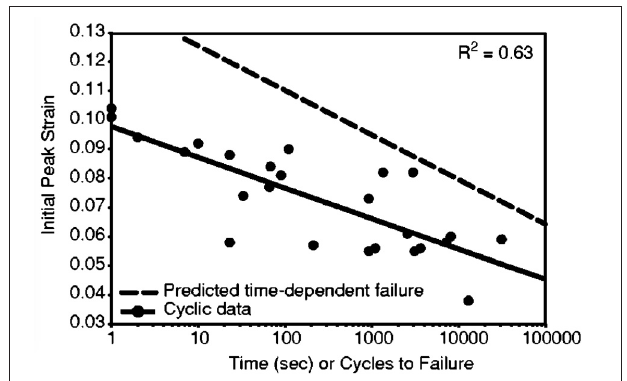
FIGURE 3 | Cyclic loading lifetime results of human oder AT specimen Achilles tendons as a function of initial (peak) tendon strain during loading and associated coefficients of determination ( R 2 ). These data demonstrate that the tendon strain magnitude determines the challenge for the tissue integrity. Greater tendon strain at a given load reduces the lifetime of the tendon during cyclic loading (Wren et al., 2003, with permission from